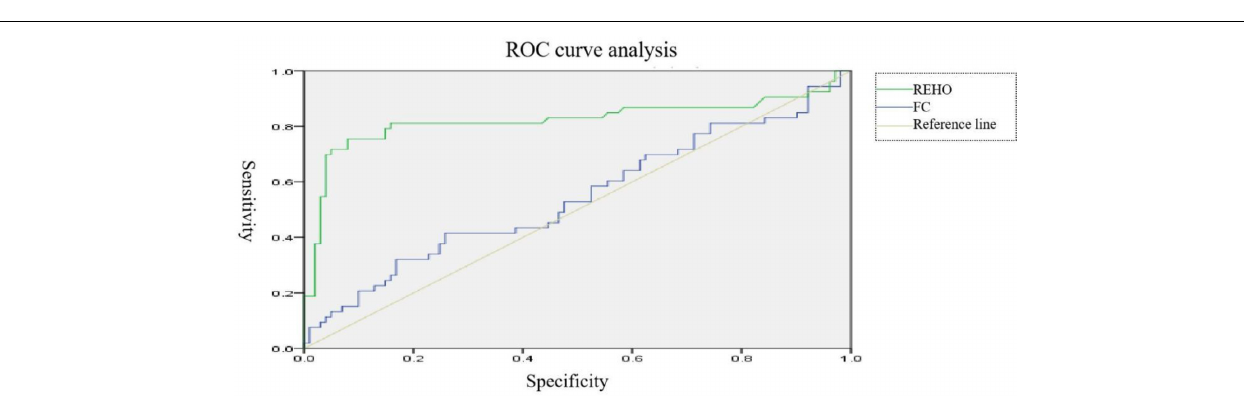
FIGURE 3 | | ROC curves for patients with major depressive disorder